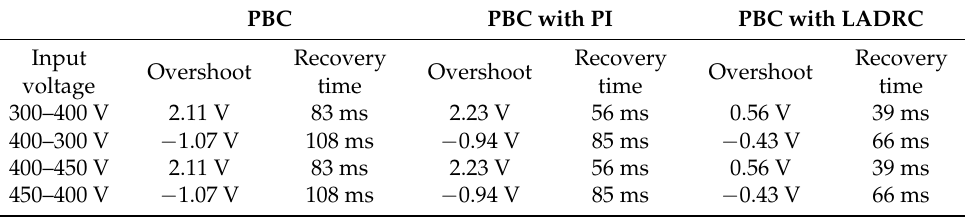
Table 5. The dynamic performance comparison during the v 2 step in step-down